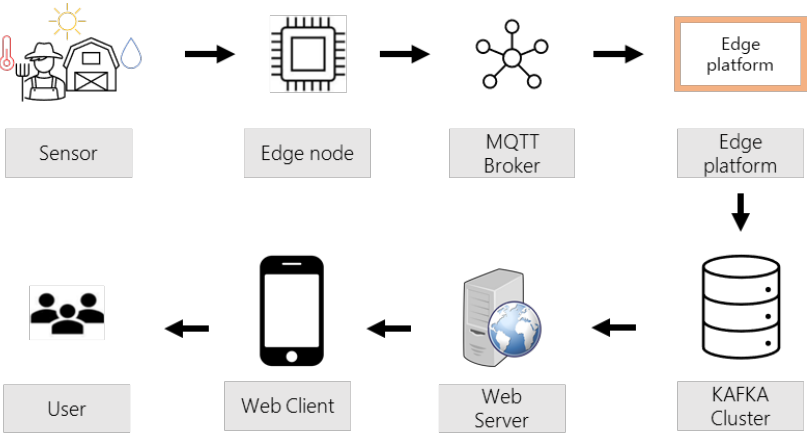
Figure 7. List of sensors and actuators and system data flow among the components.